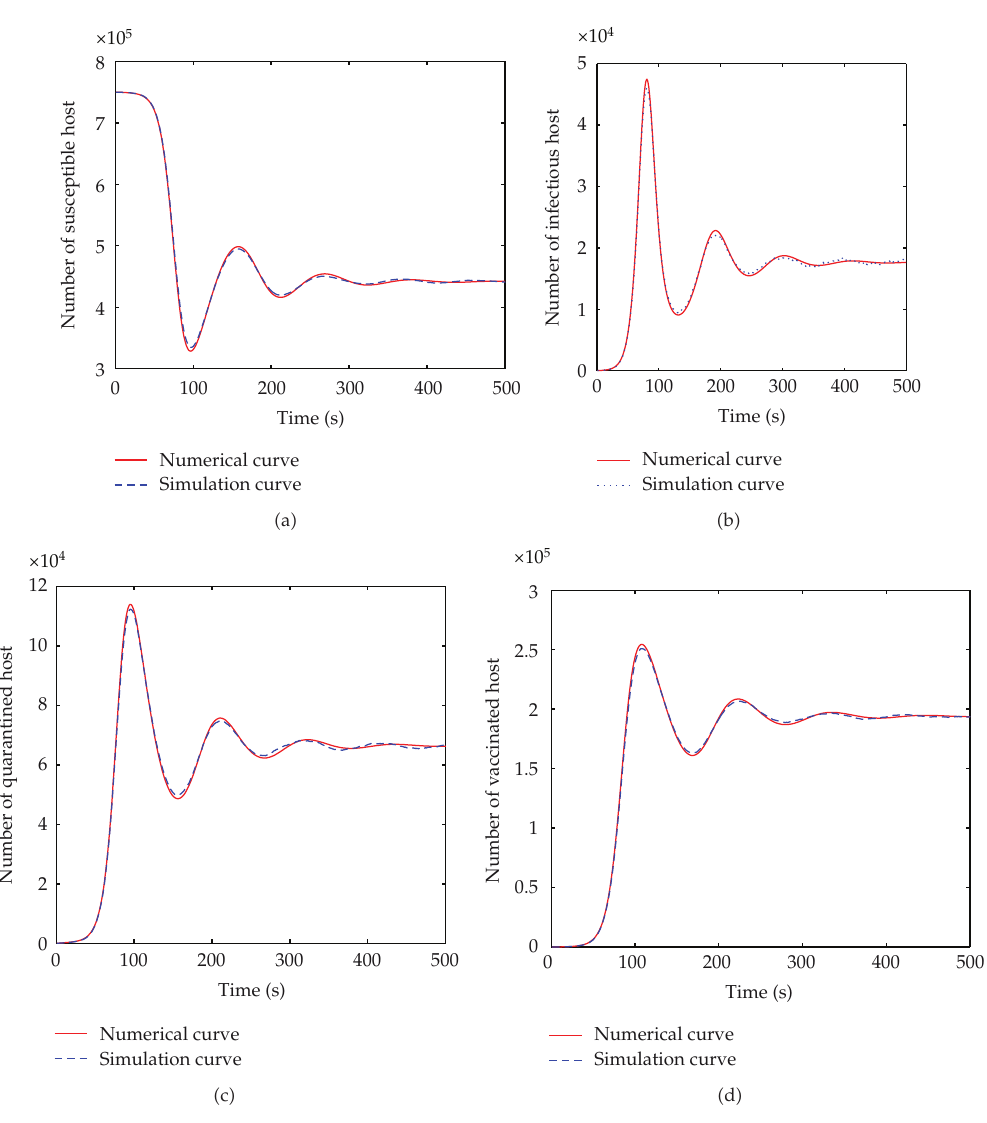
Figure 11: Comparisons between numerical and simulation curves of SEIDQV model when τ < τ 0